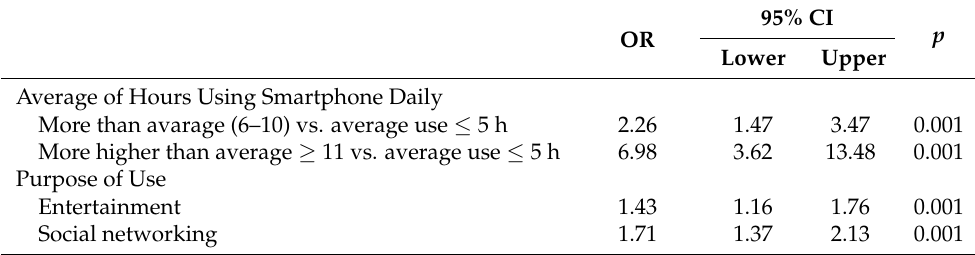
Table 6. Forward stepwise logistic regression analysis of associations of smartphone ownership, daily use, and purpose of use with smartphone addiction, N = 545.